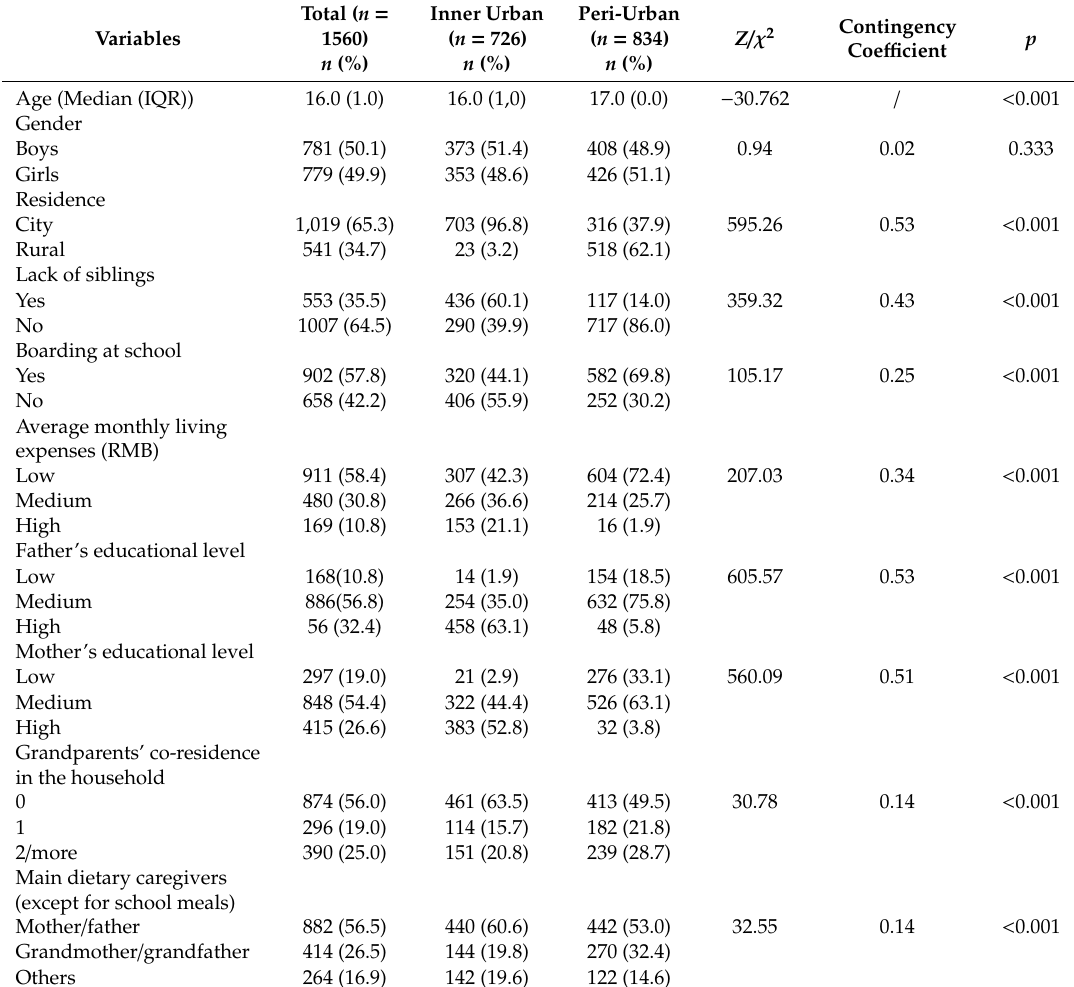
Table 1. Demographic characteristics between inner urban high school students (IUHSSs)